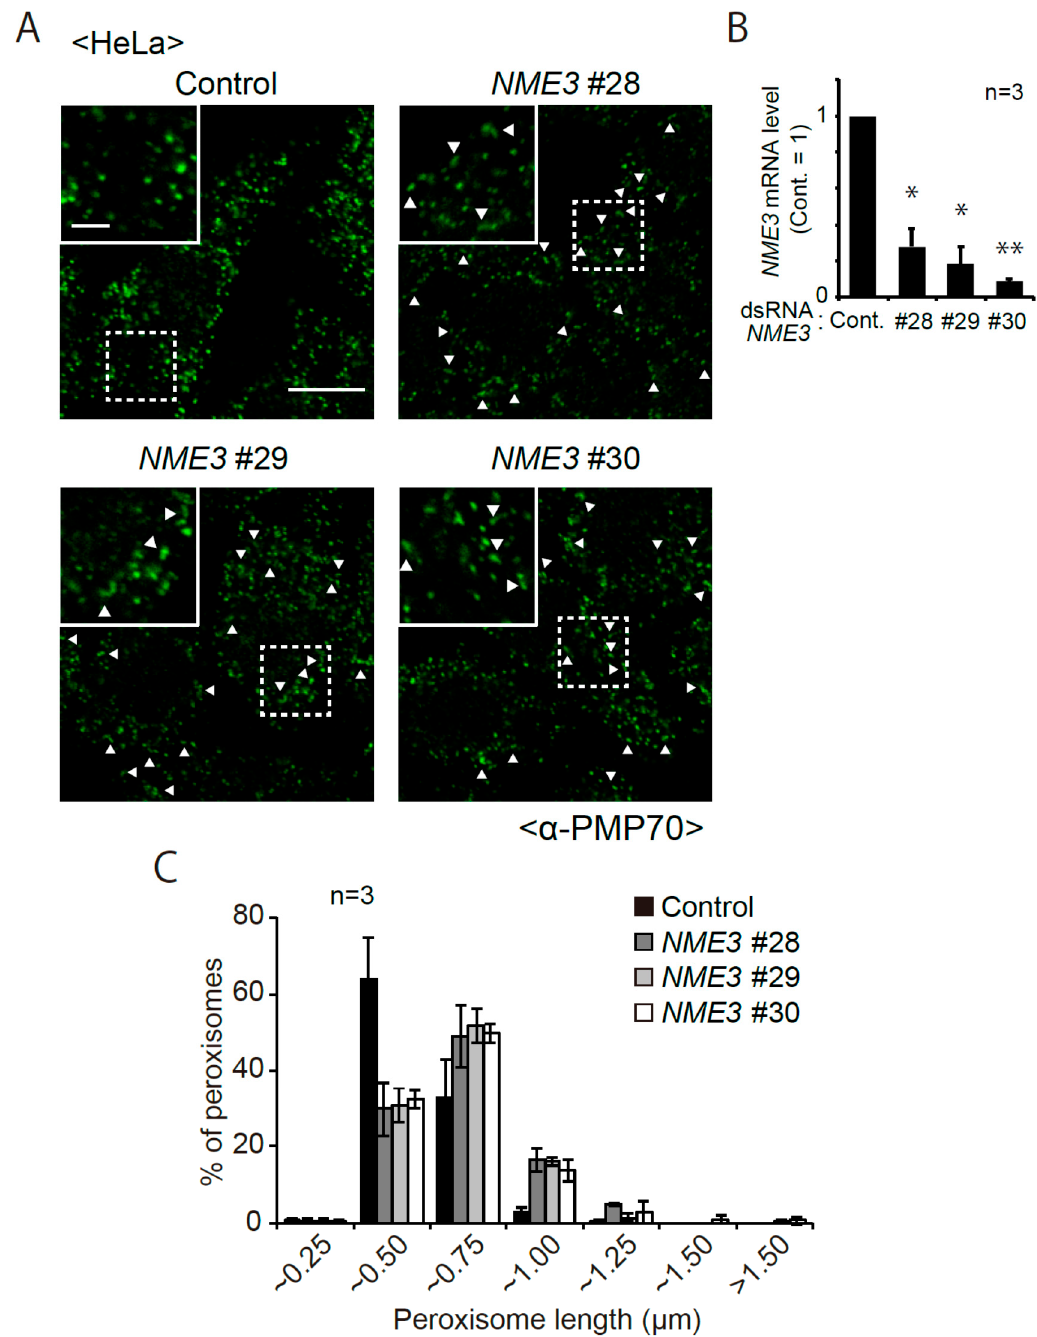
Figure 3. NME3 knockdown elongates peroxisomes. ( A ) Three different dsRNAs (#28, #29, and #30) against NME3 were transfected to HeLa cells as described in Materials and Methods. Morphology of peroxisomes was assessed with anti-PMP70 antibody. Scale bar, 10 µm. Higher magnification images of the boxed regions were shown (Inset). Scale bar, 3 µm. Arrowheads indicate elongated peroxisomes. ( B ) histogram of peroxisome length measured in three each control (totally 385 peroxisomes), ds NME3 #28- (371 peroxisomes), ds NME3 -#29- (349 peroxisomes), and ds NME3 -#30- transfected (344 peroxisomes) HeLa cells. ( C ) mRNA level of NME3 in HeLa cells that had been treated as in ( A ) was quantified by qRT-PCR (n = 3). Data indicate means ± SD. * p < 0.05, ** p < 0.01, by Student’s t -test.